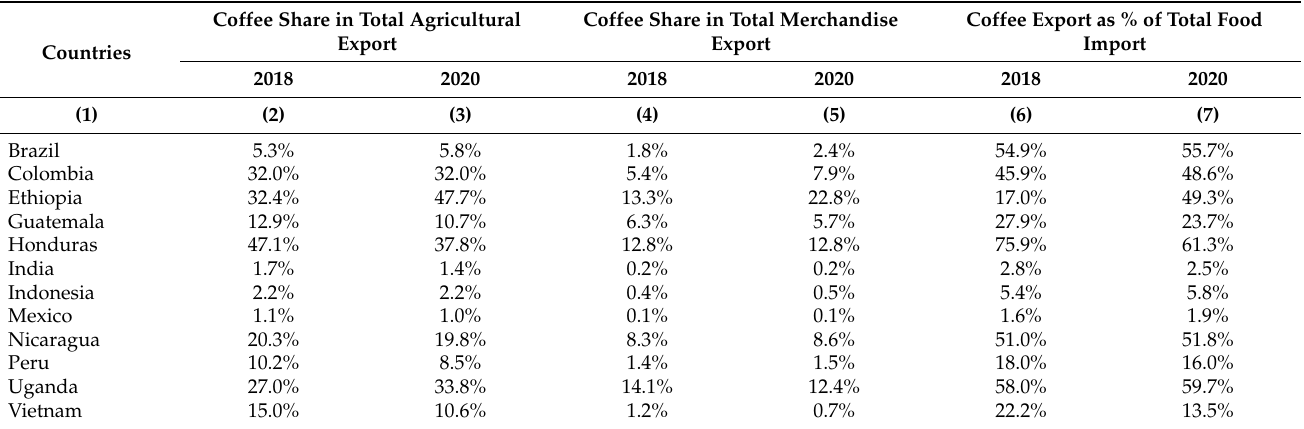
Table 2. The share of coffee compared to national export and import